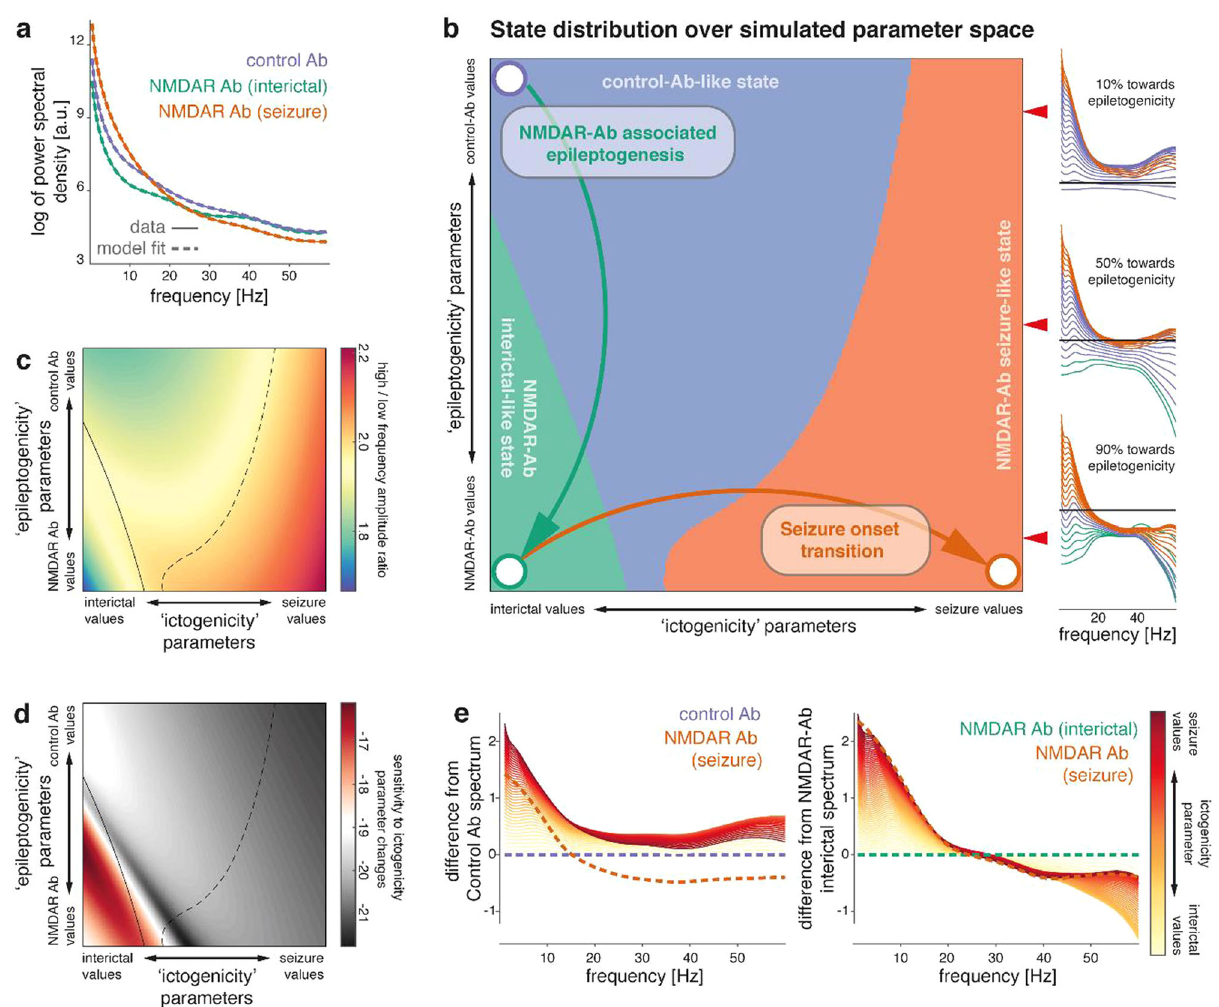
Fig. 5 NMDAR antibody pushes neuronal microcircuits towards unstable regimes. a Power spectra of LFP recordings of control antibody injected mice, and interictal and ictal states of NMDAR antibody injected mice are fi tted with neural mass models of neuronal microcircuits. Dashed lines represent the model fi t; solid lines represent the empirically measured spectra, indicating faithful reproduction of empirically measured spectral features in the fi tted dynamic causal model. b Based on the parameters derived from the dynamic causal model fi ts (represented here by circles), parameter changes that capture NMDAR antibody associated alterations in microcircuitry ( ‘ epileptogenicity ’ ) and seizure onset transition ( ‘ ictogenicity ’ ) were identi fi ed (arrows). Linear combinations of these parameters are then used to simulate spectra at different locations in a two-dimensional parameter space along both ‘ epileptogenicity ’ on the y -axis, and ‘ ictogenicity ’ on the x -axis. At each point full spectra were generated, and classi fi ed as one of three possible states ( ‘ Control antibody-like ’ , ‘ NMDAR antibody interictal-like ’ , ‘ NMDAR antibody seizure-like ’ ) based on the smallest mean-squared difference to the three empirically measured spectra. Insets show example simulations (normalized to the ‘ Control antibody ’ spectrum, indicated by the black line) at three different values for ‘ epileptogenicity ’ indicated by the red arrow heads (10%, 50%, 90% towards full ‘ epileptogenicity ’ parameter change). Each line represents a simulation at different ictogenicity values spanning the full width of ictogenicity parameters, colour-coded by their classi fi cation. c Along the ‘ epileptogenicity ’ vs. ’ ictogenicity ’ parameter space, the ratio of high frequency (>20 Hz) and low-frequency (<8 Hz) log amplitude is shown with state separating boundaries from panel ( b ) overlaid. d This plot demonstrates sensitivity to changes in ictogenicity parameters. For each given ‘ epileptogenicity ’ (i.e. row in the parameter space plot), mean-squared differences between neighbouring values of ‘ ictogenicity ’ are shown along the log-scale (a.u.) colour axis. State separating boundaries from ( b ) are overlaid. There is considerable overlap between regions in parameter space, where the microcircuit is sensitive to perturbation, and the NMDAR antibody-like state identi fi ed in ( b ). e To demonstrate differences in sensitivity to ‘ ictogenicity ’ parameter changes, spectral differences from both control Ab parmeterisation and NMDAR Ab parameterisation are shown for increasing contribution of ‘ ictogenicity ’ This map of parameter space shows that for microcircuits at control antibody parameterization, the transition to a putative seizure-like territory is further away on the ‘ ictogenesis ’ para- meter axis than it is for microcircuits at the interictal NMDAR antibody parameterization. Each of the territories is characterised by particular spectral features, illustrated in Fig. 5c by a map of high frequency and low frequency amplitude ratios across the same parameter space.